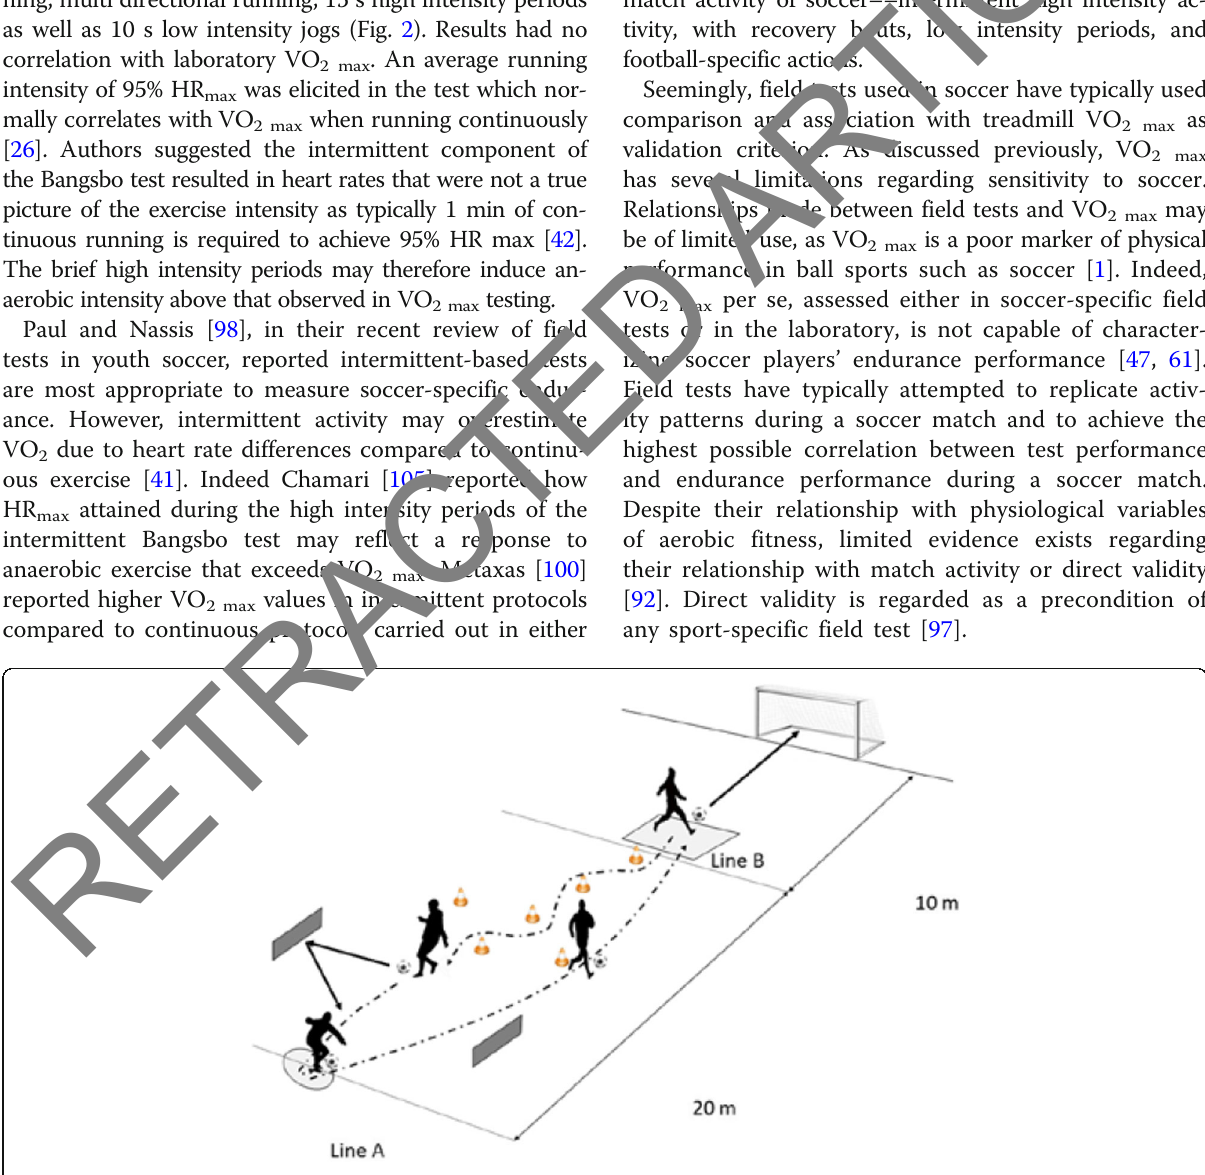
Fig. 2 The spatial lay out of the “ Foote-Val